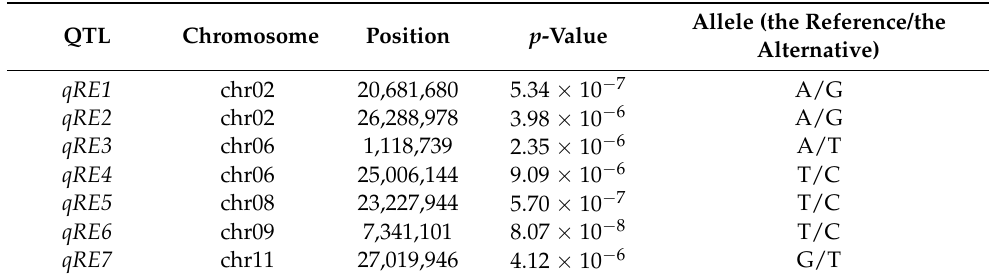
Table 2. Novel QTL for root elongation under high Zn toxicity in Ting’s core